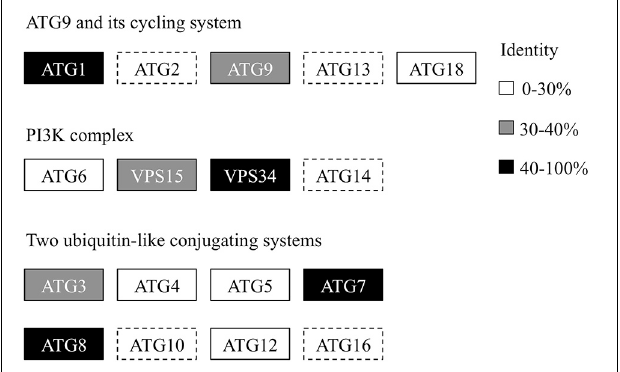
FIGURE 1 | Genome-wide identification of the autophagy core machinery genes in A. protothecoides . Dotted lines indicate missing genes. Boxes show the yeast ATG homologs detected in A. protothecoides . The identity level of each gene is indicated by